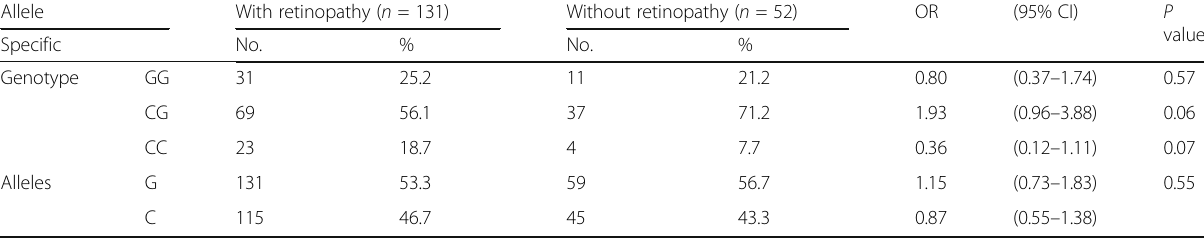
Table 3 Genotype frequency of C-1214G polymorphism of SDH gene in patients with and without DR Allele